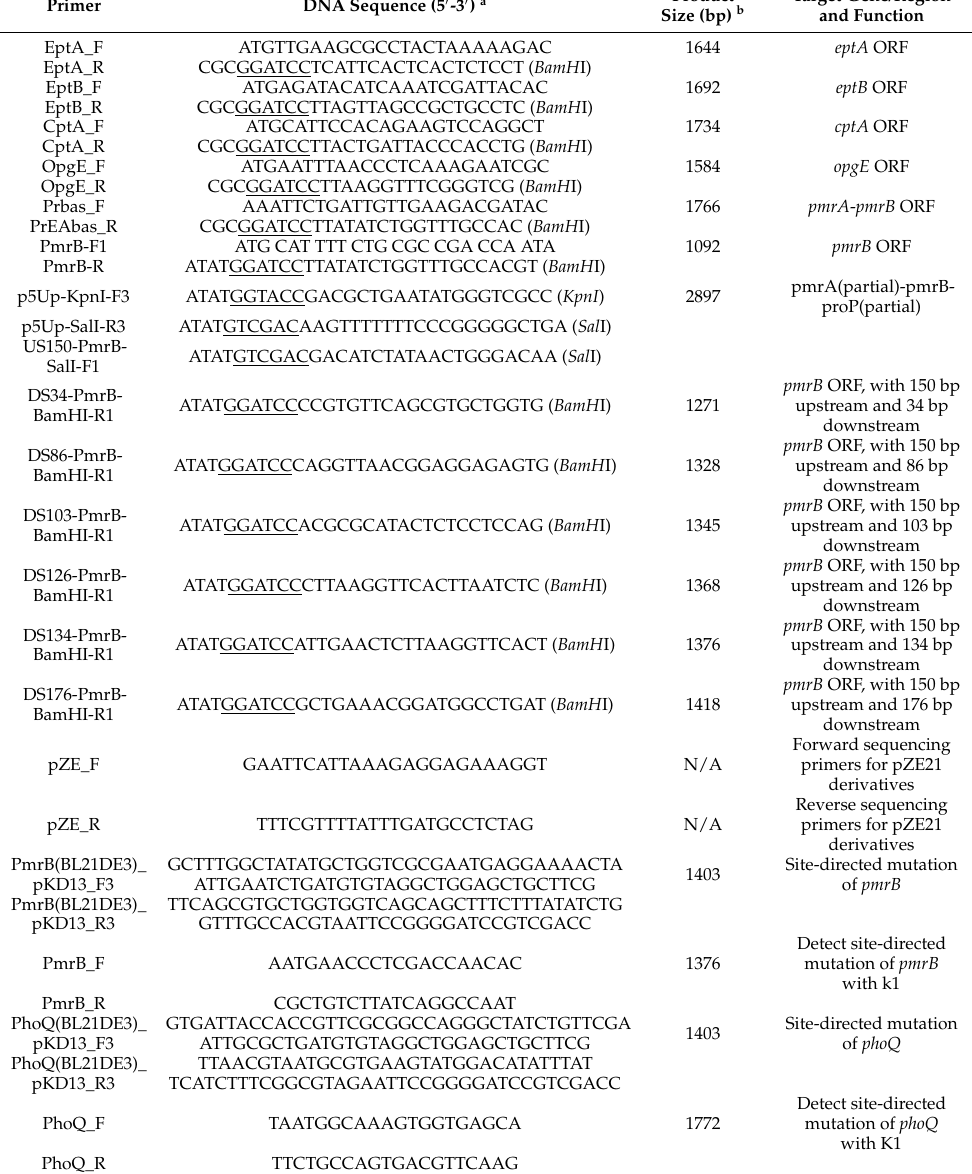
Table 2. Major primers used in this